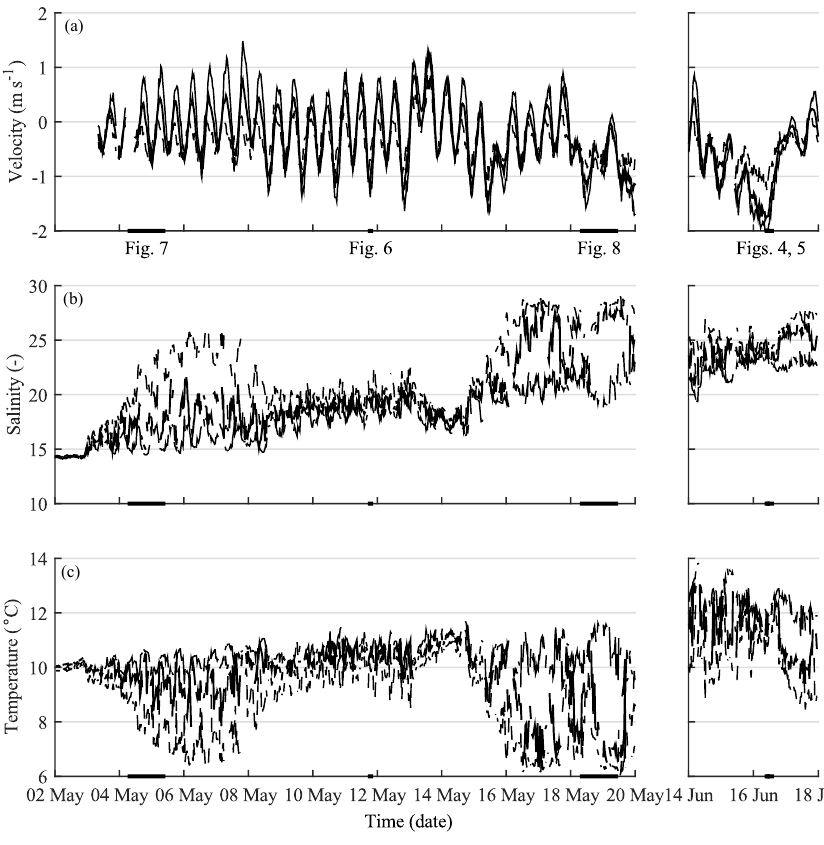
Figure 3. Time series of observations from the station at the Old Bridge (see Fig. 1) for 2 to 19 May and 14 to 17 June 2004. (a) Shows velocity measurements projected onto the main flow direction, positive values for northward flow through the Little Belt. The curves are the depth-averaged value (solid, thick), the bin box at a depth of about 5m (solid, thin), and the bin box at 3m above the bottom (dashed, thin). The total depth at the station is about 37m. (b, c) Show the salinity (in Practical Salinity Units) and the temperature, respectively, measured at a depth of 5m (solid, thin curve), 15m (solid, thick curve), and 22m (dashed, thin curve). The timings of the observations shown in Figs. 4 to 8 are indicated by the short, thick lines on the x axes, specified in the upper panel. (Some of the curves may be difficult to distinguish. Note though that the less saline and warmer water is found near the